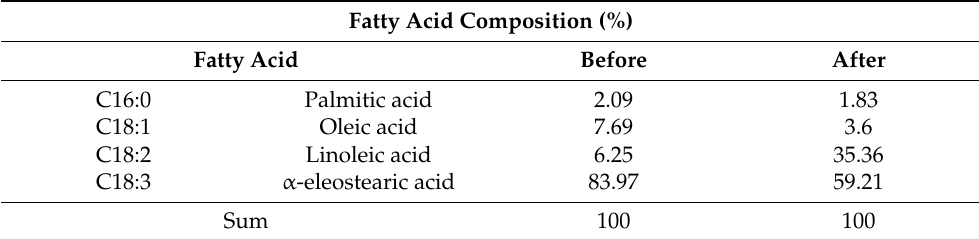
Table 1. Comparison of fatty acid composition of tung oil before and after fermentation.